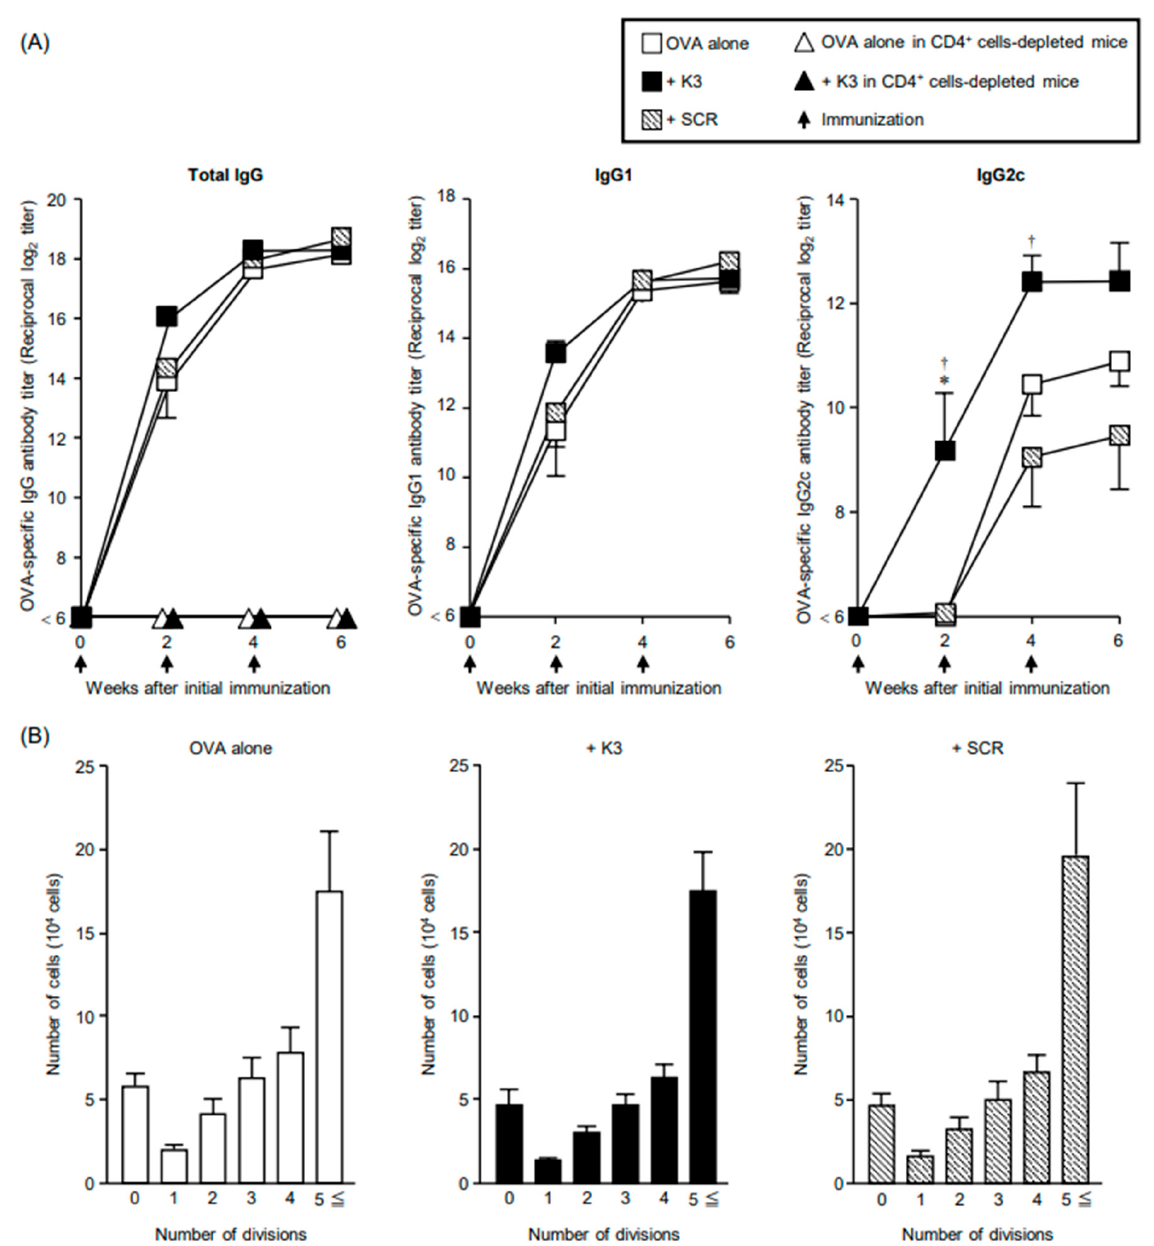
Figure 1. Ovalbumin (OVA)-specific antibody response and T-cell proliferation using the OVA-self-dissolving microneedle patch (sdMN) and K3-loaded hydrophilic gel patch (HG) methods. ( A ) C57BL/6 mice were injected intraperitoneally with anti-CD4 or isotype control antibody for 3 d consecutively, then once every 4 d. These mice were immunized using the OVA-sdMN and HG methods with OVA, OVA + K3, or OVA + scramble (SCR) three times every two weeks. Sera collected after immunization were assayed to determine the OVA-specific total IgG, IgG1, and IgG2c titers using ELISA. Data are expressed as mean ± SE of results from three-five mice (Tukey-Kramer method, * p < 0.05 versus OVA alone, † p < 0.05 versus + SCR). ( B ) Fluor 670-labeled OT-II cells (CD4 + , CD45.1 + ) were transferred into C57BL/6 live mice (CD45.2 + ). The next day, these mice were immunized using the OVA-sdMN and HG methods with OVA, OVA + K3, or OVA + SCR. After 3 d, the proliferation of transferred OT-II cells (CD4 + , CD45.1 + ) in draining lymph nodes (dLNs) was analyzed using flow cytometry. The number of divisions was detected via fluorescence intensity of eFluor 670 and the number of OT-II cells are shown for each division. Data are expressed as mean ± SE of results from three-four